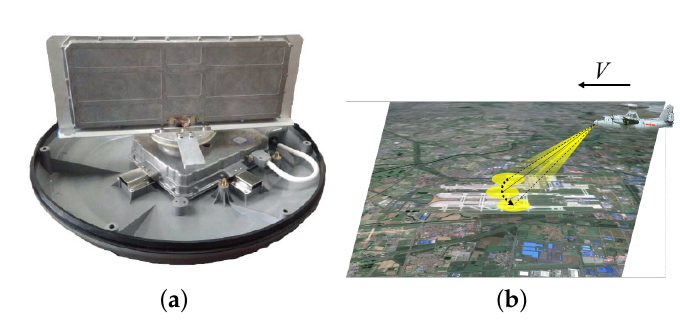
Figure 6. The experiment system and imaging model. ( a ) The millimeter-wave radar; ( b ) The forward-looking scanning imaging model.